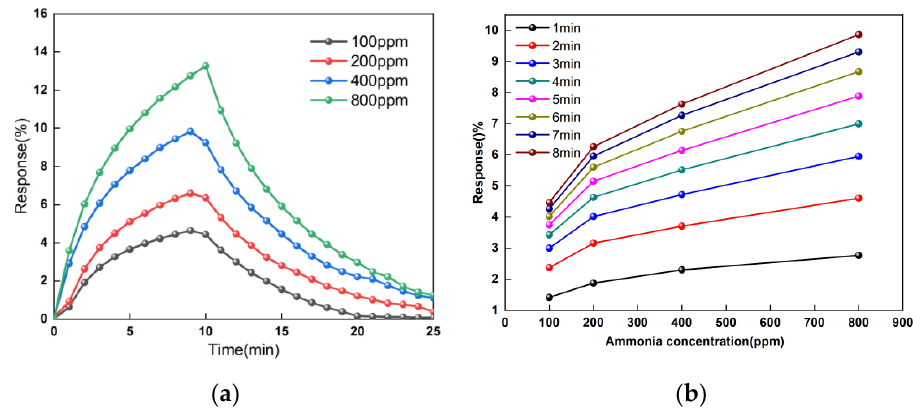
Figure 7. The concentrations response of the sensor. ( a ) The response of the sensor with time. ( b ) The response of the sensors with NH 3 gas concentration.